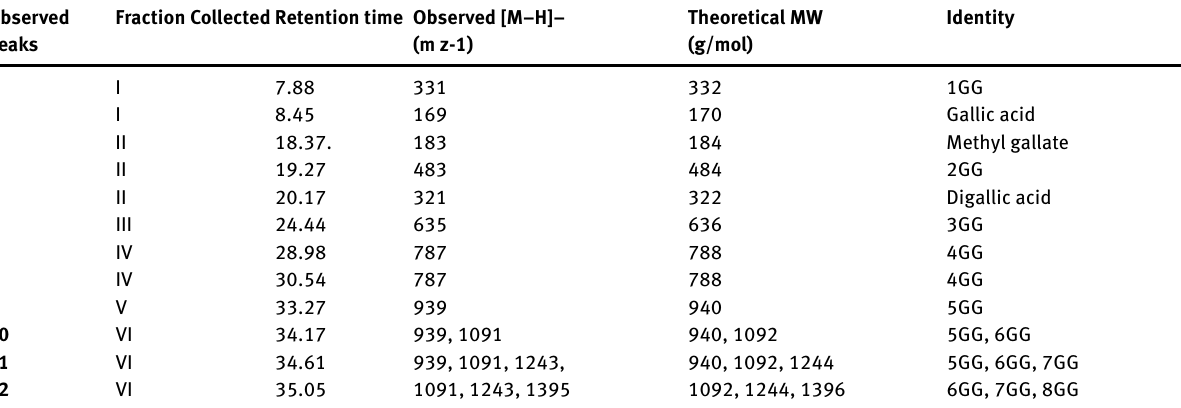
Table 2: Major compounds in CG extract in 70% methanol, according to LC-MS analysis Observed